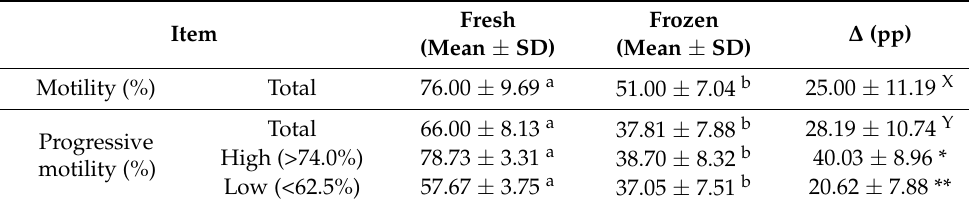
Table 2. Effect of cryopreservation on motility and progressive motility of bull spermatozoa.